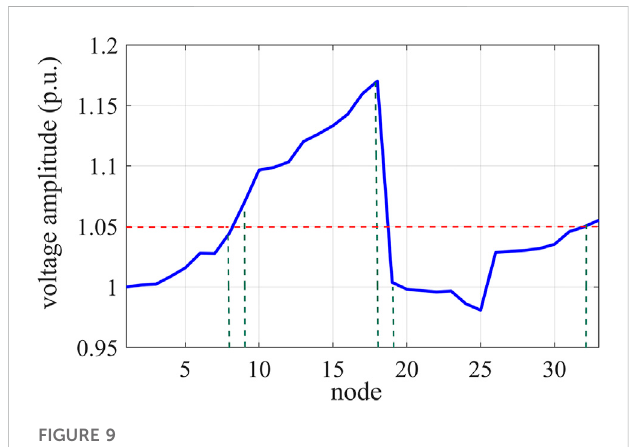
FIGURE 9 Voltage amplitude of each bus node without control.